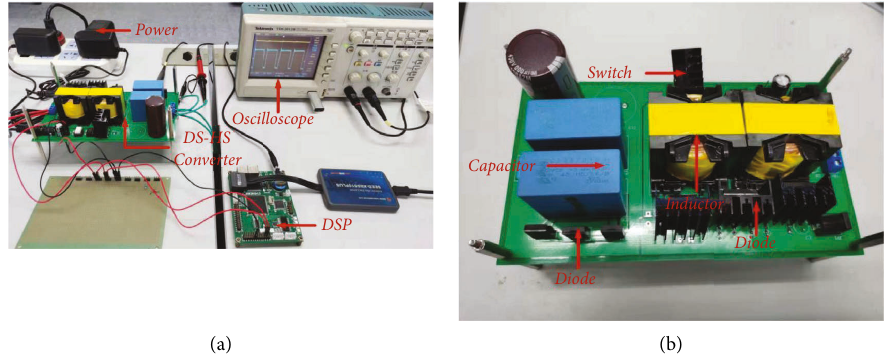
Figure 14: The DS-HS converter. (a) The experimental prototype and (b) the enlarged